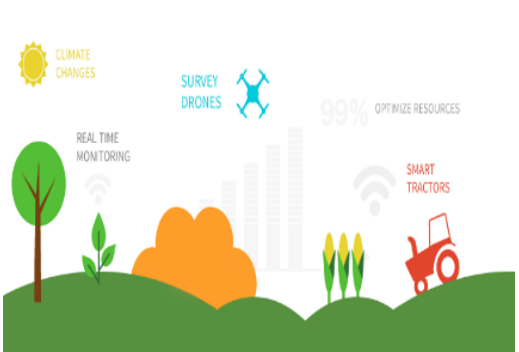
Fig. 2. IOT Applications in Industry